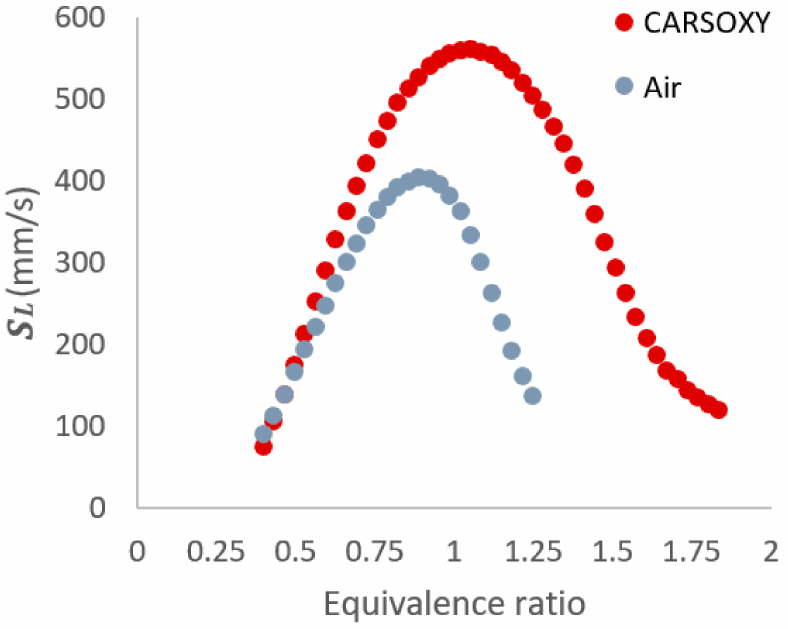
Figure 7. S L for a CH 4 /air flame and a CH 4 /CO 2 -A r -O 2 flame at a range of equivalence ratios.